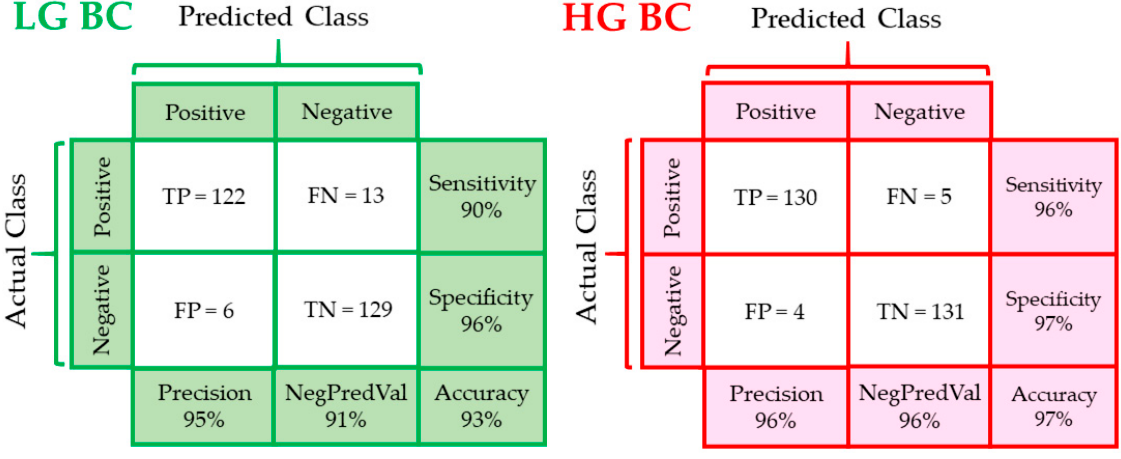
Figure 5. Confusion matrices for N vs. LG BC groups and N vs. HG BC, calculated from PLS-DA results. Abbreviations: TP—true positive, FN—false negative, FP—false positive, TN—true negative, NegPredVal—negative predictive